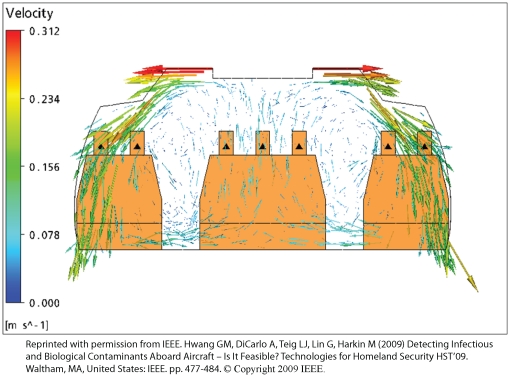
4” Mesh Velocity Contour.